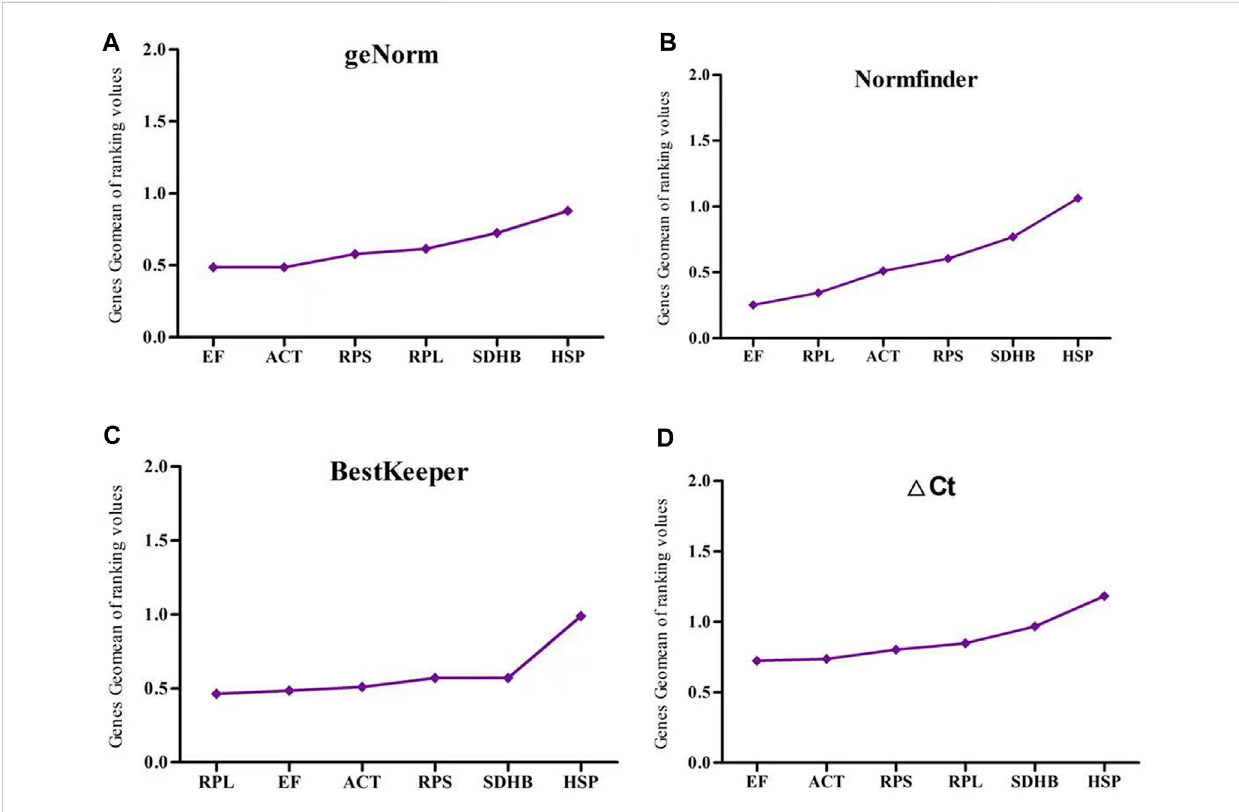
FIGURE 5 The stability of six reference gene different temperature treatment samples of Megalurothrips usitatus genescalculated by the Geomean method of RefFinder. (A) , geNorm; (B) , NormFinder; (C) , BestKeeper; (D) , Δ